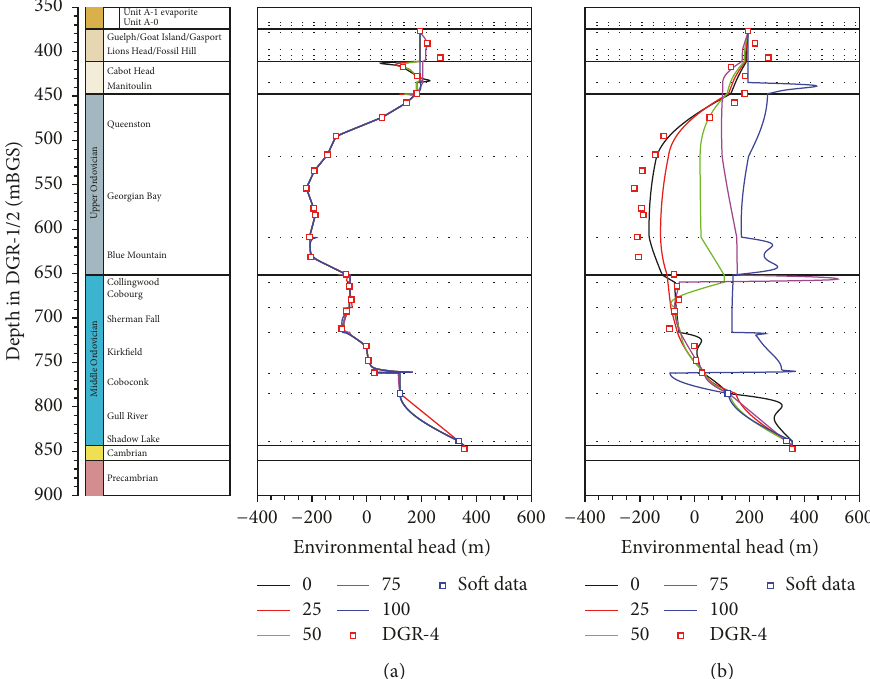
Figure 7: Heads at the end of ten paleohydrogeologic simulations using glaciation scenario nn9930. Coloured lines represent different percentages of ice-sheet thickness applied as excess head to the top boundary condition. Subfigure (a) uses present day environmental heads as the initial condition while subfigure (b) uses a hydrostatic head condition computed assuming steady-state.